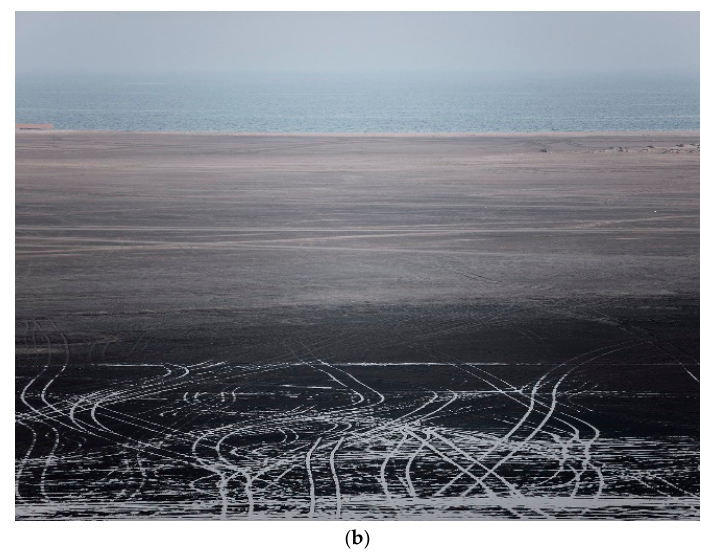
Figure 9. Jaber’s ‘Nationalism 1’ ( a ) and ‘Survival 13’ ( b ) (2016). ‘Border-lines’. (Printed on cotton rag fine art archival paper.) Used by permission of the artist.